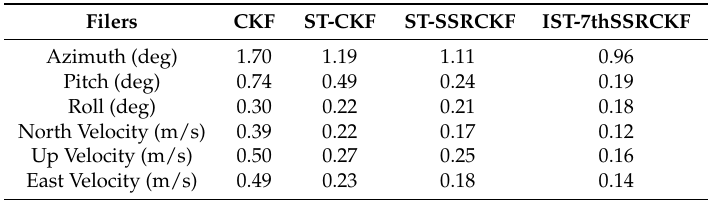
Table 4. RMSEs of different filters in the maneuvering stage when M =